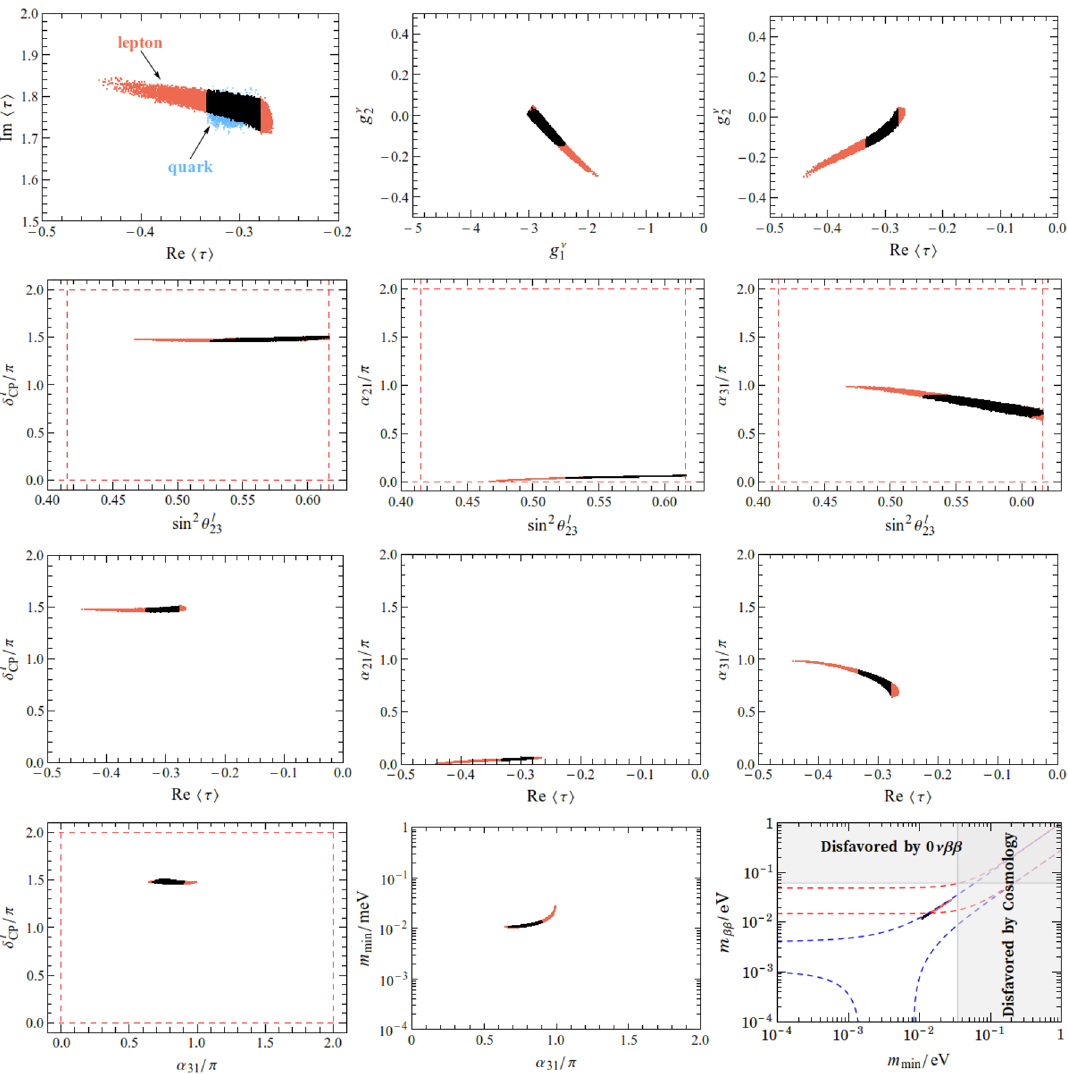
Figure 3 . The predictions for the correlations among the input free parameters, neutrino mixing angles, CP violation phases and neutrino masses of the unified model L convention as figure